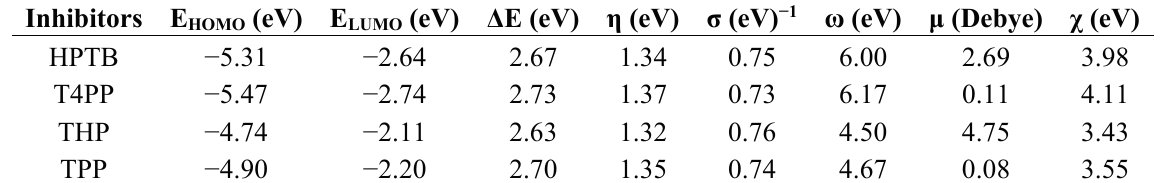
Table 4. Quantum chemical parameters for the studied